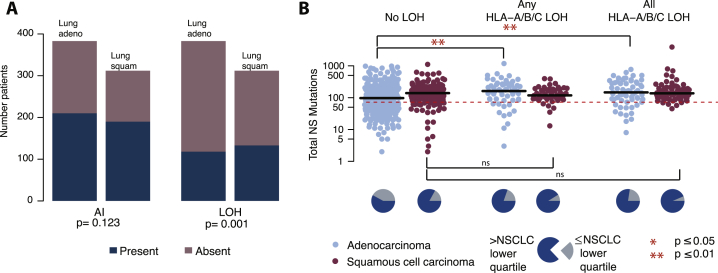
Frequency and Association with Mutational Burden of HLA LOH in TCGA, Related to Figure 5(A) The total number of TCGA patients exhibiting an allelic imbalance or LOH at the HLA locus is shown.(B) The total number of nonsynonymous mutations is plotted across different categories of HLA LOH for lung adenocarcinoma (light blue) and lung squamous cell carcinomas (magenta). Tumors were classified as having: no HLA LOH; any HLA LOH event; or HLA LOH at all three HLA loci. The lowest total non-synonymous mutation quartile is indicated by the dashed red line and the proportion of tumors with a total non-synonymous mutational burden greater or less than that is indicated by the pie charts for each HLA LOH classification group.